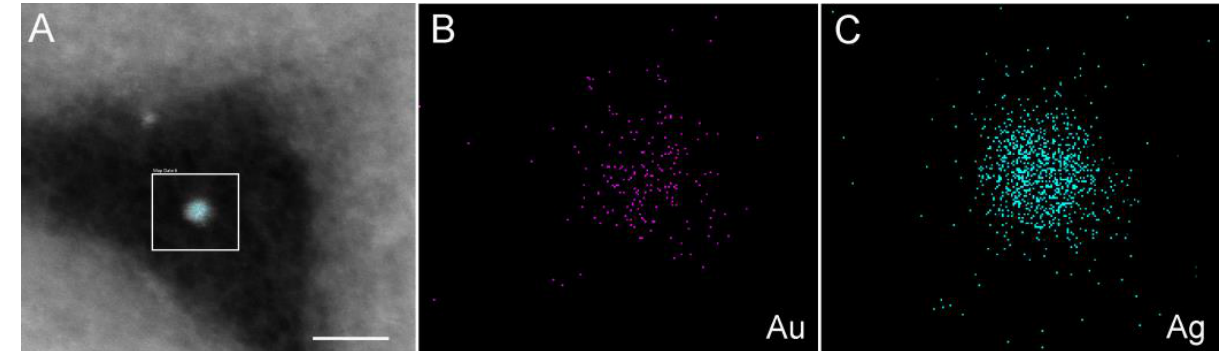
Figure 4. Detailed HAADF-STEM image of AuAg-g-C 3 N 4 nanohybrid 3 displaying a 4 nm size metal nanoparticle. EDS elemental mapping images for elements Au and Ag: image ( A ) displays both elements mapping at a time, while images ( B , C ) display the individual Au and Ag elemental maps, respectively (bar corresponds to 10 nm).